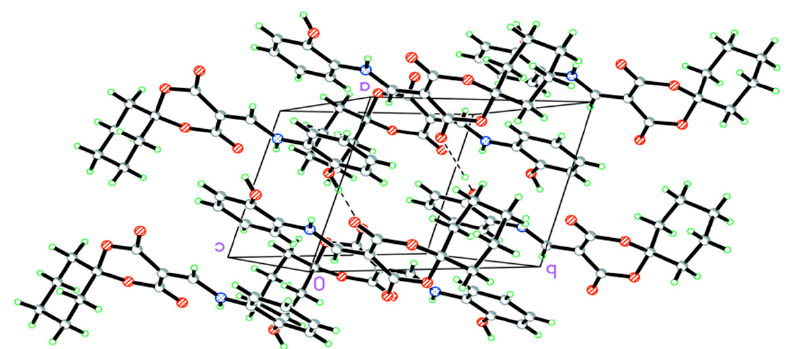
Figure 3. The packing arrangement of HMD. Table 3. The hydrogen bonds for HMD.